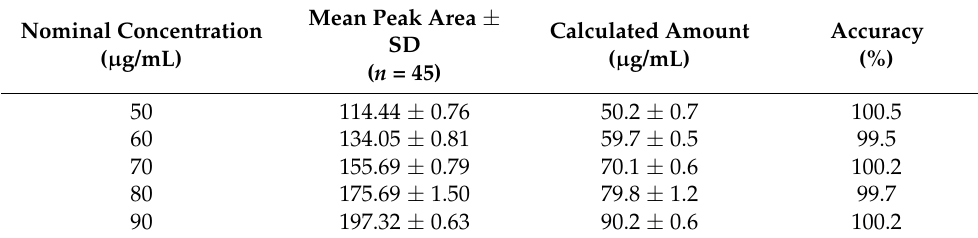
Table 1. Linearity study of the stability-indicating analytic